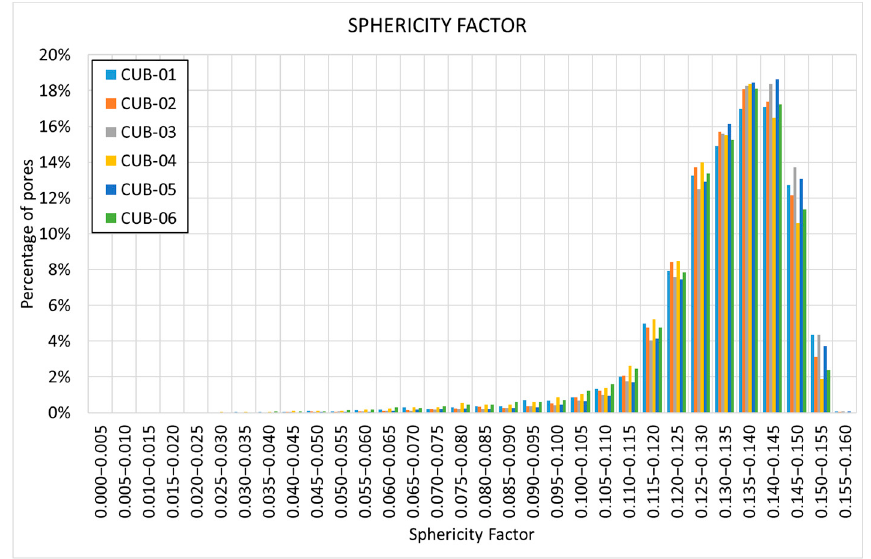
Figure 23. Histogram of the sphericity factor.